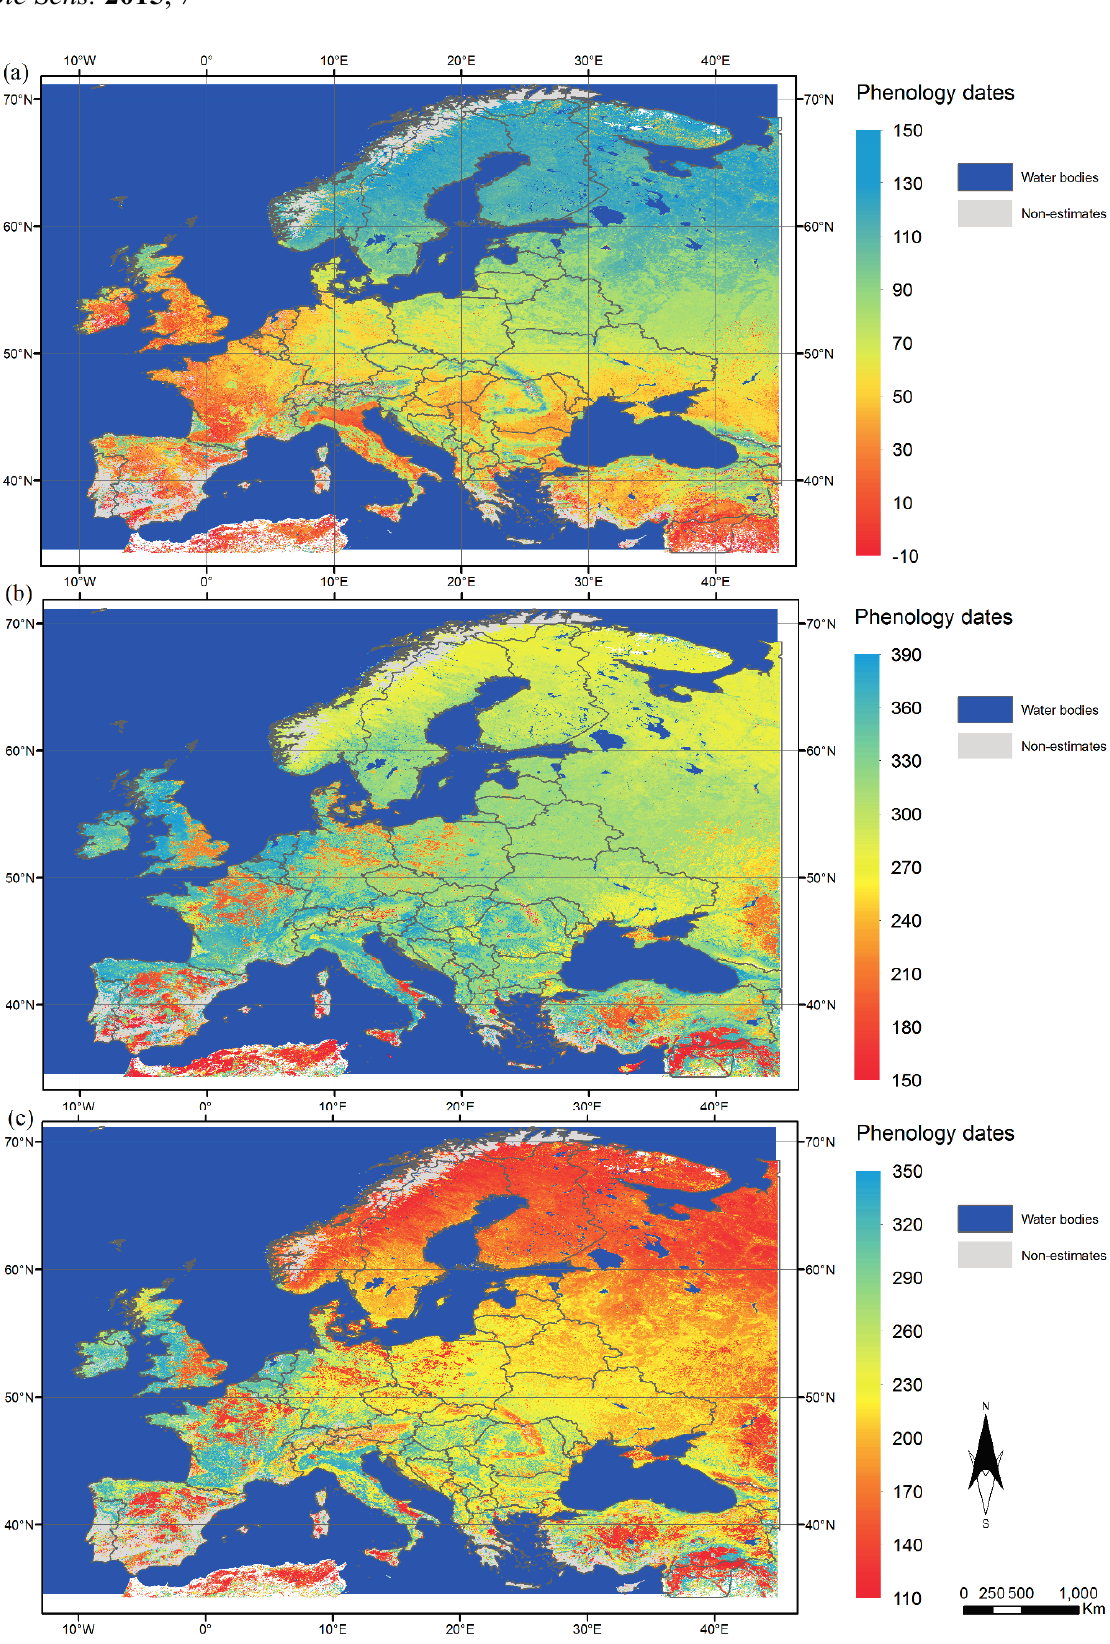
Figure 2. Phenology maps of Europe. ( a ) Onset of greenness (OG); ( b ) end of senescence (EOS); ( c ) length of the season